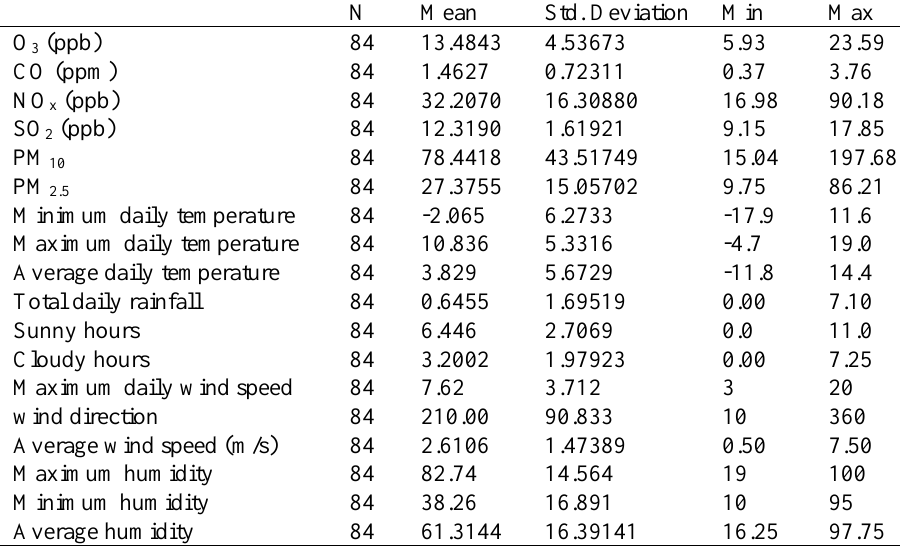
Table 1. Dispersion of the used data